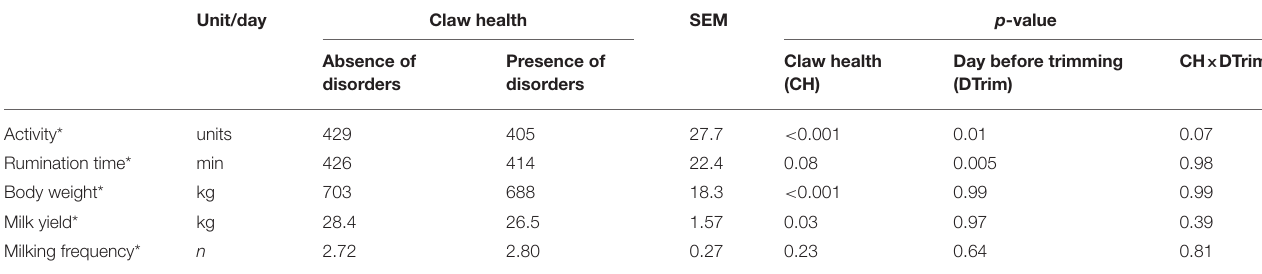
TABLE 2 | Effects of claw health (absence of disorders, presence of disorders) on daily activity, rumination time, body weight, milk yield, and milking frequency of 15 multiparous Holstein cows during the 15-day period preceding two hoof trimming events, at the former of which they were diagnosed without claw disorders, and at the latter of which they were found affected by some